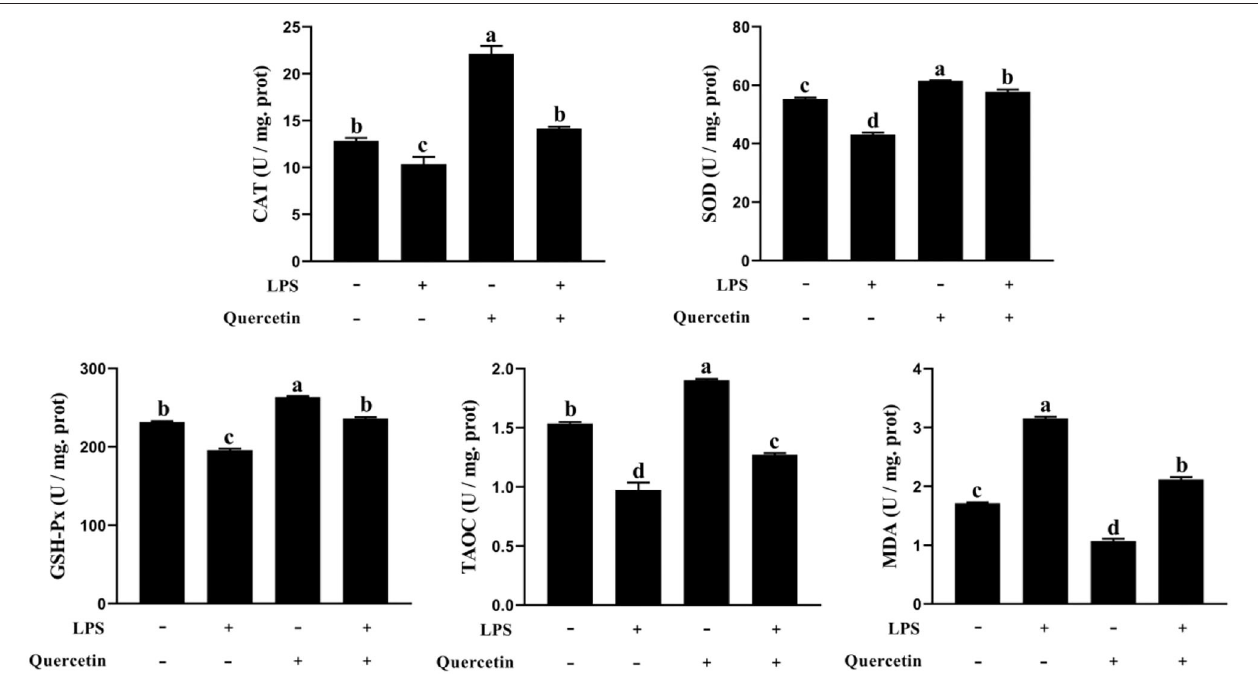
FIGURE 2 | Effects of 100 µ g/ml of quercetin on oxidative properties of 1 µ g/ml of LPS-treated BMECs. BMECs were treated with 1 µ g/ml of LPS and 100 µ g/ml of quercetin. After 6h of culture, the cells were collected. Catalase (CAT), superoxide dismutase (SOD), glutonium peroxidase (GSH-Px), total anti-oxidant capacity (TAC), and malondialdehyde (MDA) were measured in cell samples using the antioxidant related assay Kit. Data presented are mean ± SEM ( n = 3). Different lowercase letters in the bar chart indicate significant differences ( P <